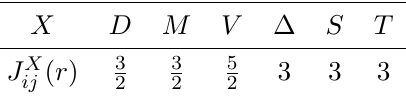
Table 5 . Exact values of the dimensionless integrals J X from the potentials I X the potentials V LL